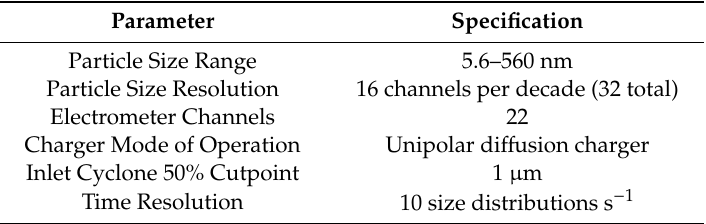
Table 6. Engine Exhaust Particle Sizer (EEPS)